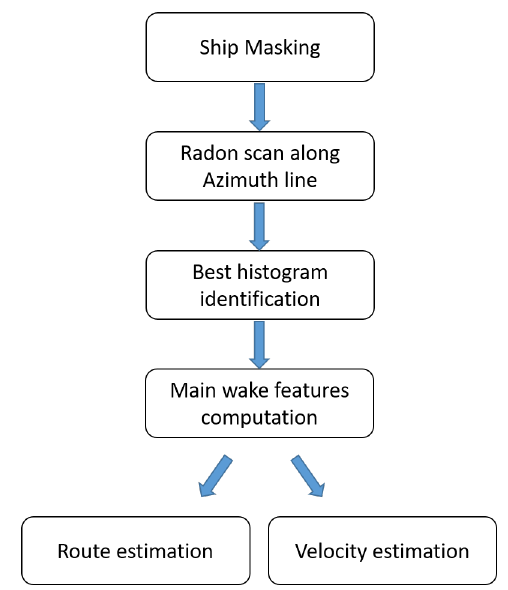
Figure 7. Conceptual diagram of the vessel kinematics